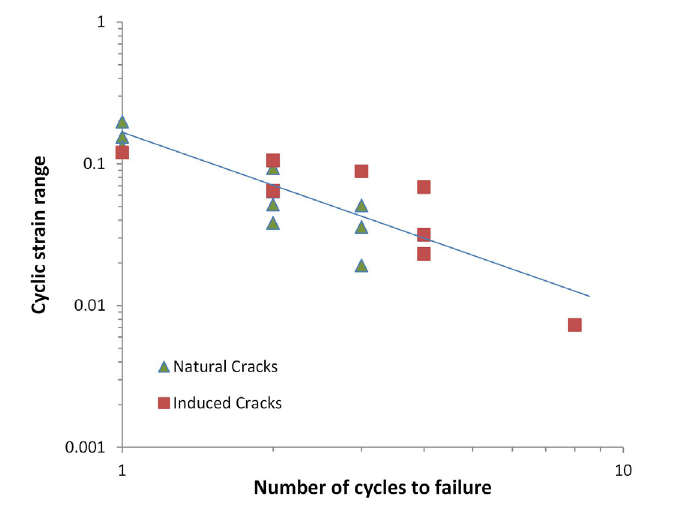
Figure 6: Strain-life data for osteocyte cellular